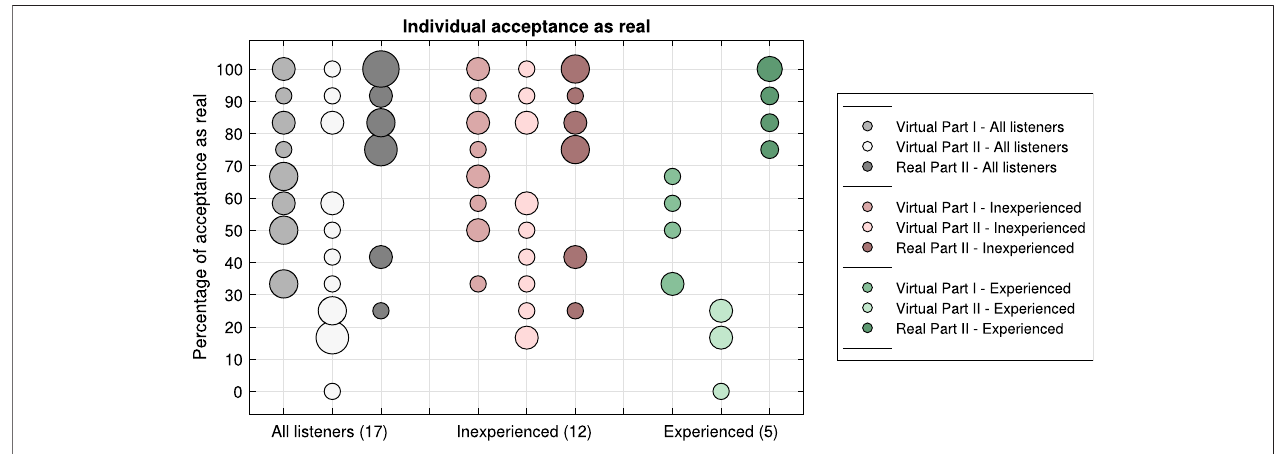
FIGURE5| Percentageoftestscenes whichwereratedasrealbythe17individualparticipants,aswellasInexperienced andExperiencedListenersseparatelyfor the scenes with the virtual reproduction in Part I and Part II of the experiment and the real scenes in Part II.